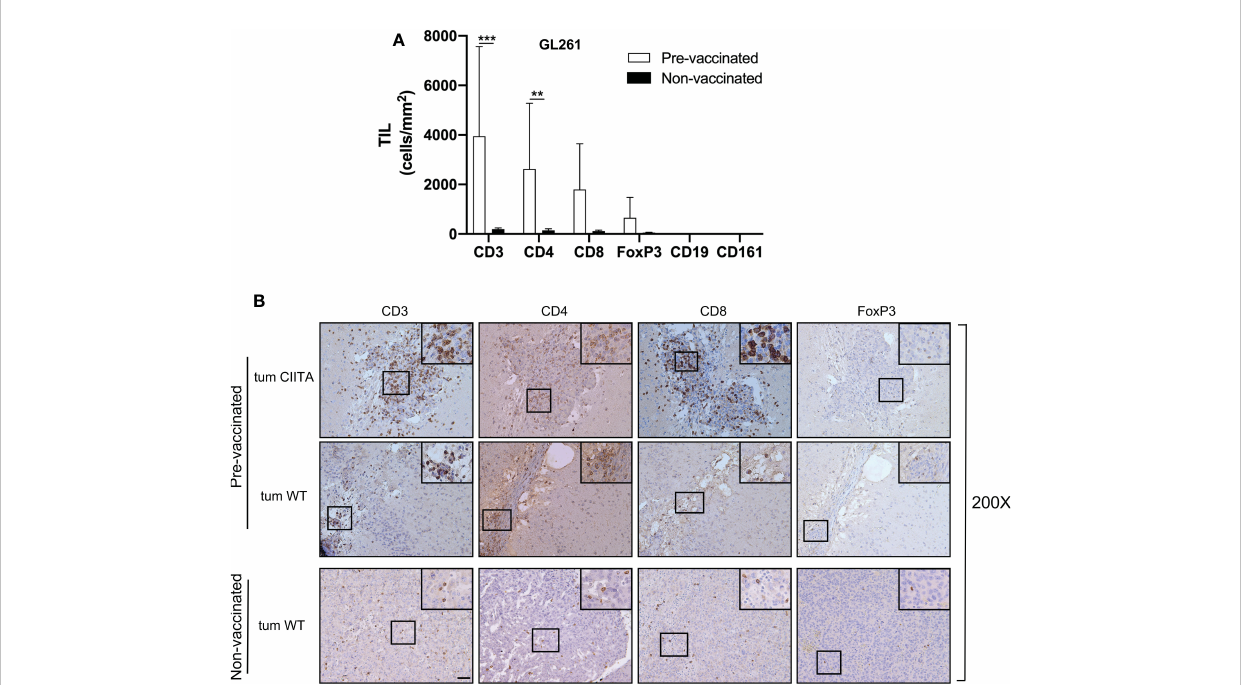
FIGURE 7 Rejected GL261 parental tumors in pre-vaccinated mice are strongly in fi ltrated by CD4 T cells. (A) Bars represent the average number of listed tumor-in fi ltrating lymphocytes (TILs) in the GL261 parental tumor site of GL261-CIITA pre-vaccinated or non-vaccinated mice. Bars represent mean values, and error bars indicate the SD within each group, n = 5. p -Values were determined via unpaired t-test; CD3: ***p < 0.001; CD4 : **p < 0.01; the average number of both CD8 and FoxP3 did not differ signi fi cantly between the two groups. CD19 and CD161 were not signi fi cantly represented. (B) Representative immunohistology images of tumor sections as described in (A) The fi rst series of horizontal panels depict GL261-CIITA tumors in pre-vaccinated mice at 42 days after inoculum (pre-vaccinated, tum CIITA), stained for the speci fi c markers listed at the top. The second series of panels depict GL261 parental tumors in GL261-CIITA pre-vaccinated mice (pre-vaccinated, tum WT). The fi nal series of horizontal panels depict GL261 parental tumors in non-vaccinated mice (non-vaccinated, tum WT). Small square boxes are the areas represented in the corresponding large square boxes of each IHC image. Images were taken at ×200 magni fi cation; scale bar corresponds to 50 m M. Large square boxes were taken at ×400 magni fi cation. Note that selected areas in IHC images of GL261 parental tumors of non-vaccinated mice are taken in the rare zones in which positive cells for the selective marker were present. IHC,